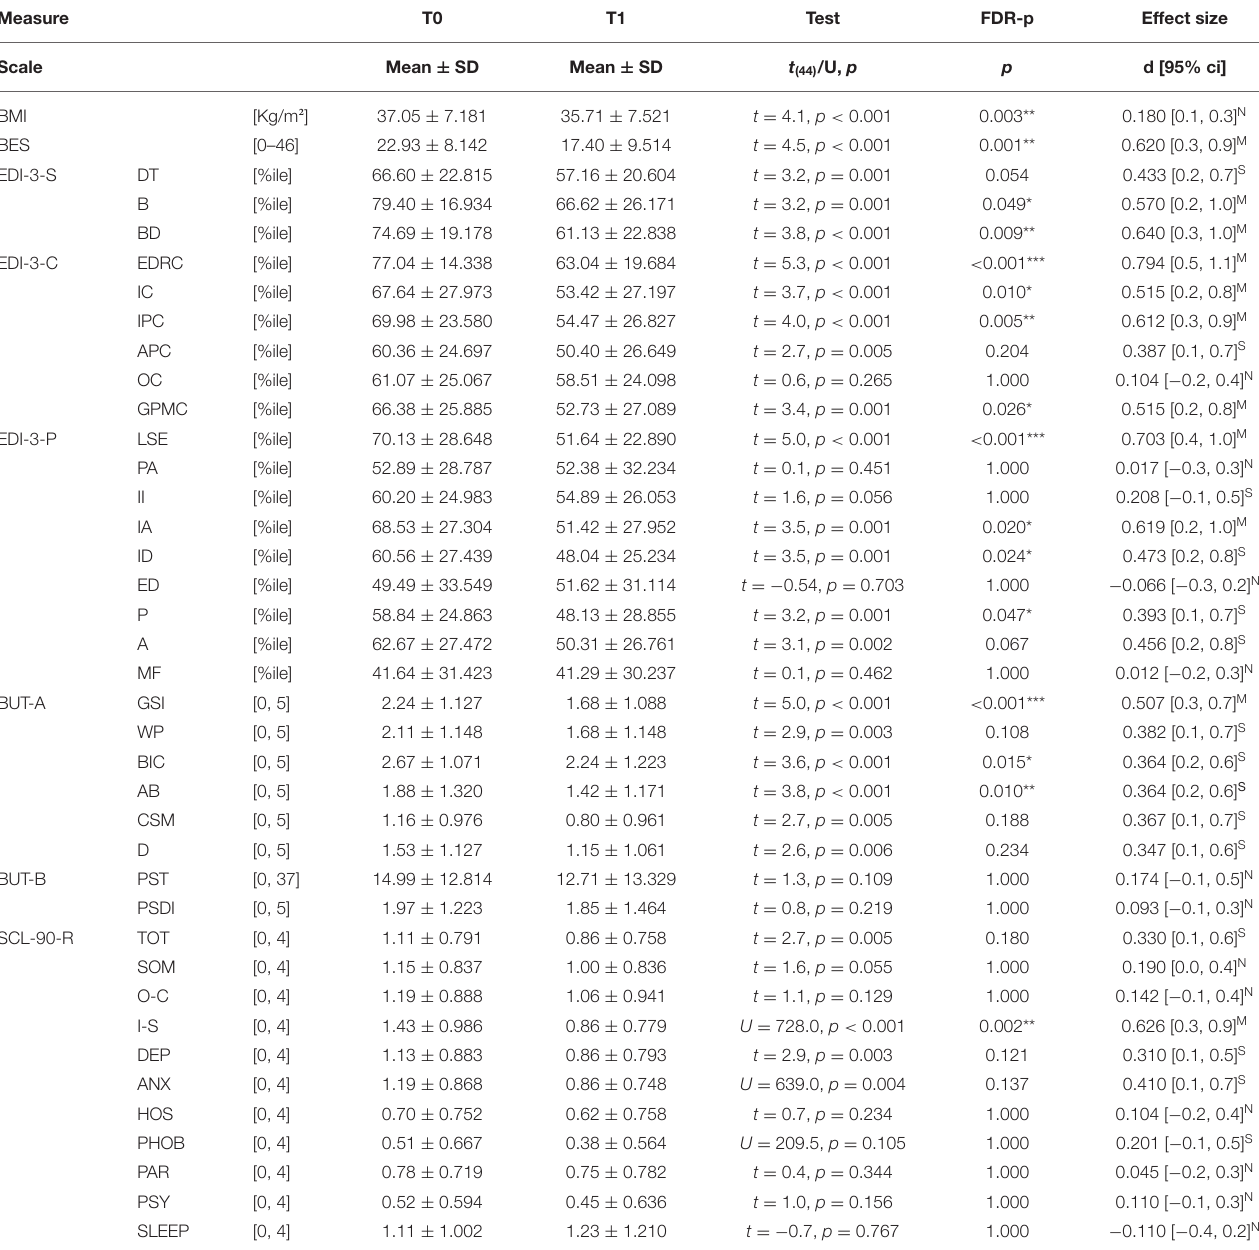
TABLE 3 | Pre-post (T0-T1) 12-weeks intervention